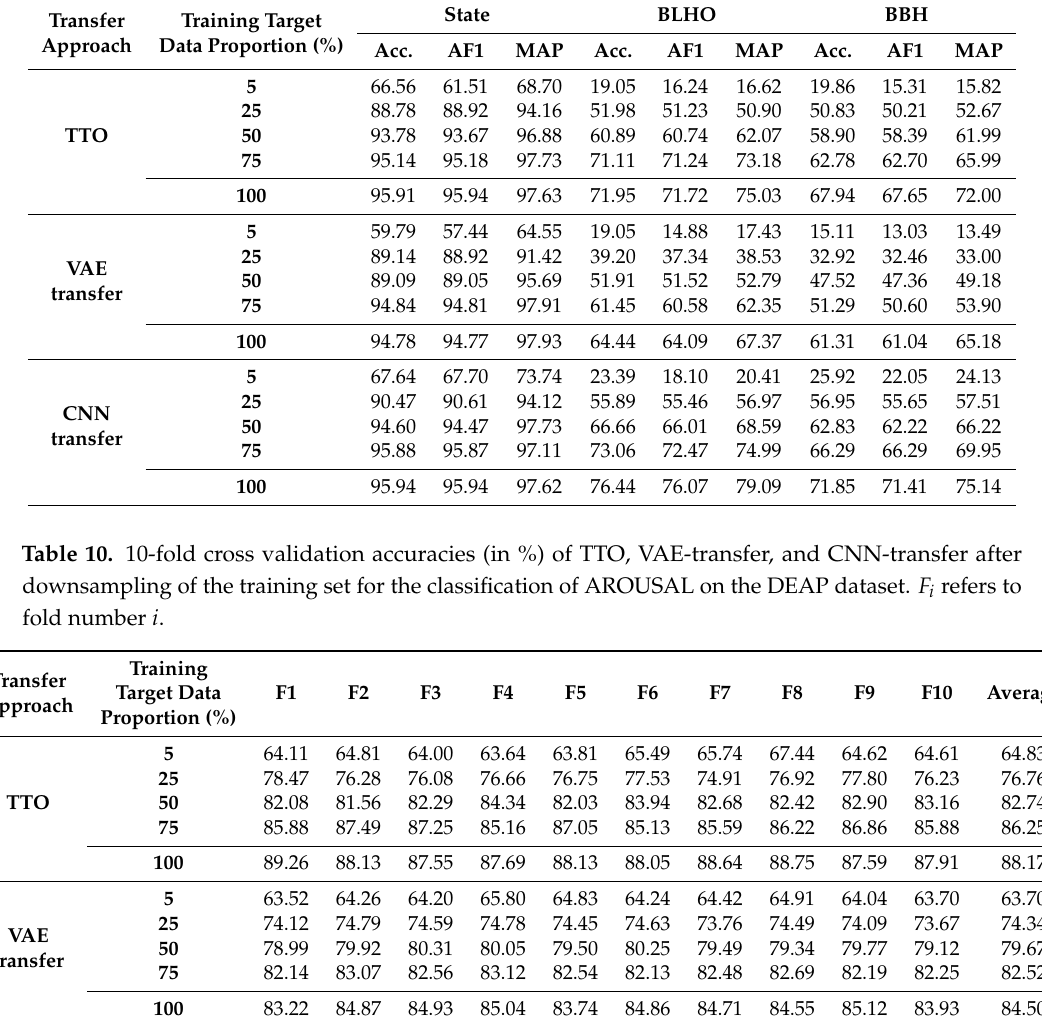
Table 9. Accuracies, AF1s, and MAPs (in %) of TTO, VAE-transfer, and CNN-transfer after downsampling of the training set, for the classification of state, BLHO, and BBH activities on the CogAge dataset (subject-dependent configuration).